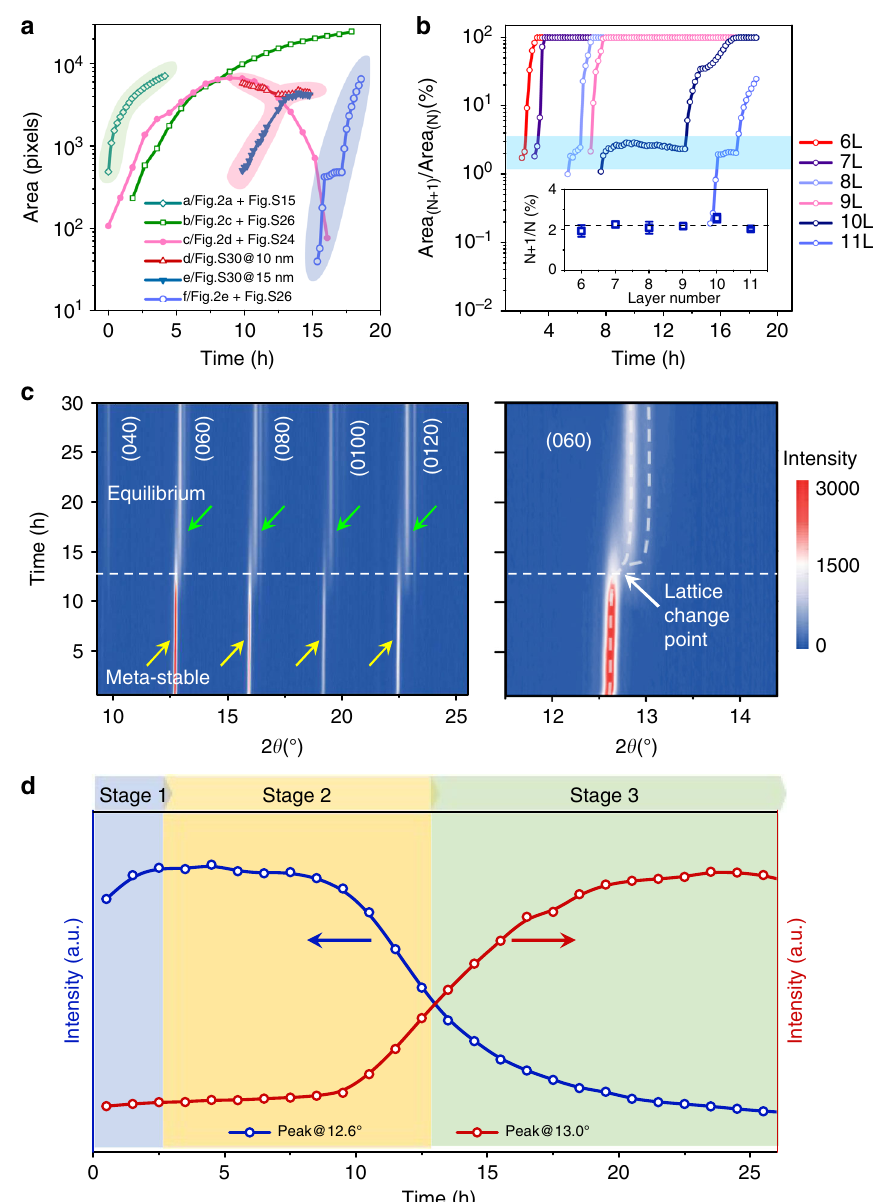
Fig. 3 Quantitative growth kinetics of the biomimetic self-assembly trajectories. a Plots of the domain area as a function of the growth time. These domains are highlighted in Fig. 2a, c, d and 2e; Supplementary Figs. 15, 24, 26 and 30. b Area ratio of the upper layer ( N + 1) and the base layer ( N ) during the layer growth mode. Inset shows a constant area portion of ~2.2%. Error bars represent the standard deviations from an average of three samples. c Time evolution of fi lm X-ray diffraction patterns showing the transition of crystalline phases in a 1 mg/mL C 7 P – BTBT fi lm sample at room temperature (25 °C). Right inset: Magni fi ed lattice evolutions of the decreasing peak at ~12.6° and two newly produced peaks at ~13.0°. Colour scales from blue (low intensity) to red (high intensity). d Peak intensity evolutions extracted from the peaks of ~12.6° and ~13.0°, which can be divided into three stages (Stage 1: light blue; Step 2: orange; Step 3: